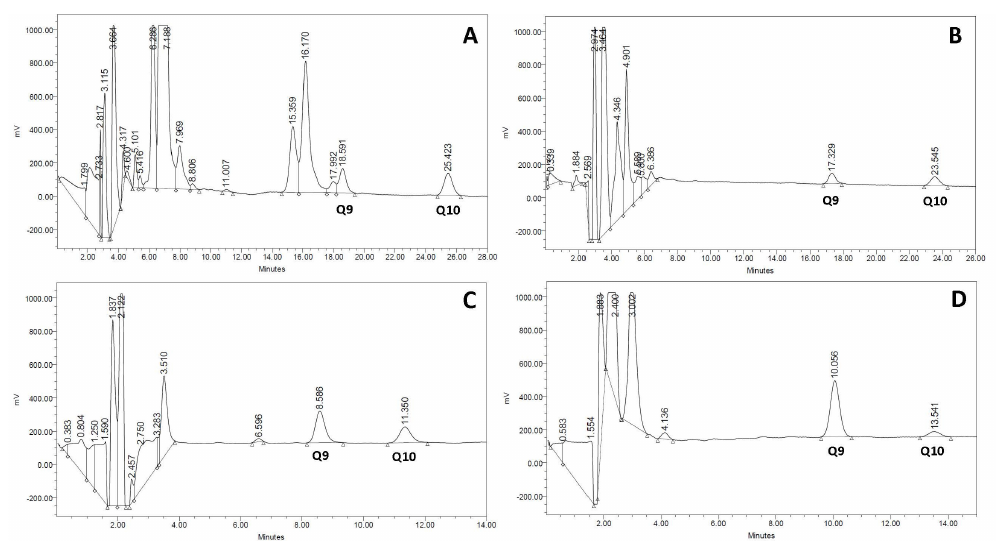
Figure 1. Normal Coenzime Q 10 (CoQ) chromatograms of different biological specimens. ( A ) serum; ( B ) urine; ( C ) muscle; ( D ) cultured skin fibroblasts. In each specimen, type Q 9 and Q 10 have a different retention time that is related to differences in sample matrices and the high-pressure liquid chromatography (HPLC) column length required for separation.